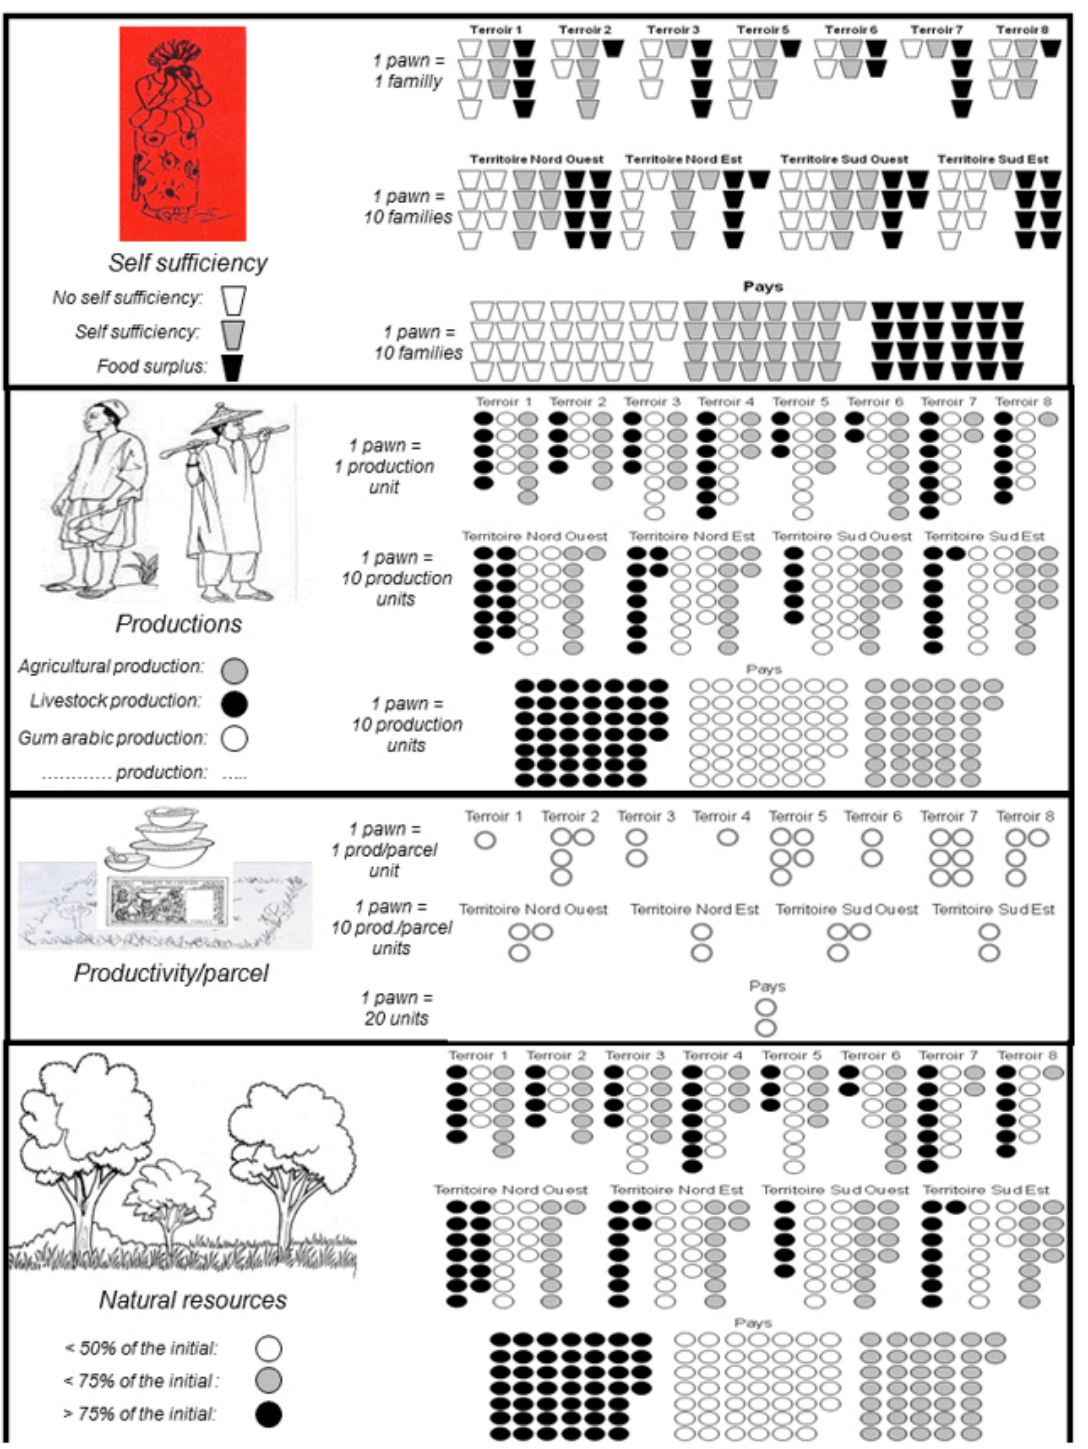
Fig. 3 . Participatory framework for coassessment of the scenario indicators